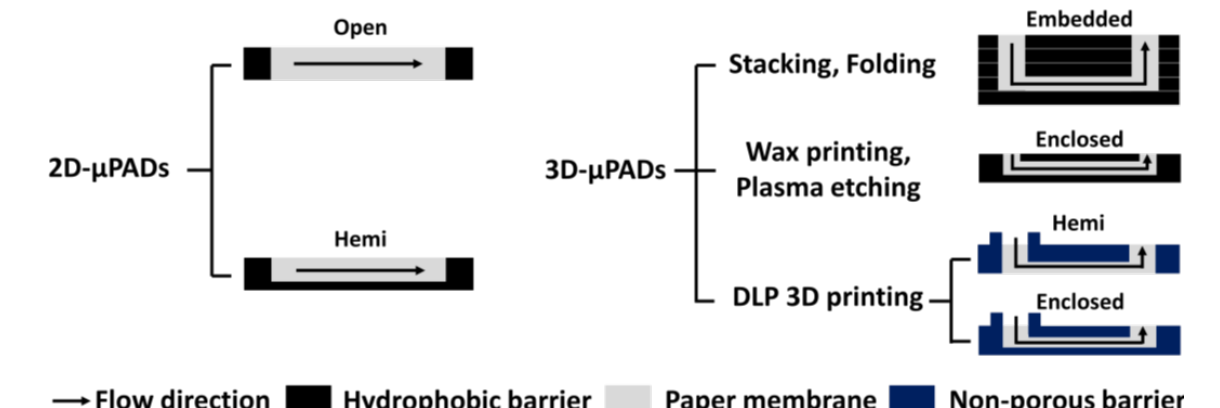
Figure 1. Cross-sectional views of different 2D- and 3D-μPADs classified by their channel type.